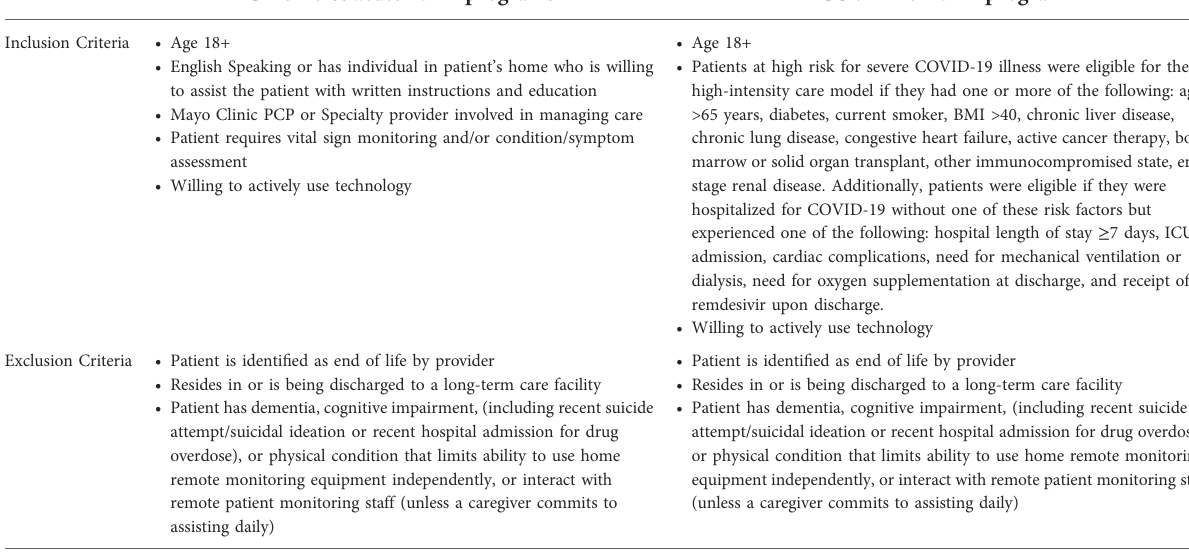
TABLE 2 General remote patient monitoring inclusion and exclusion